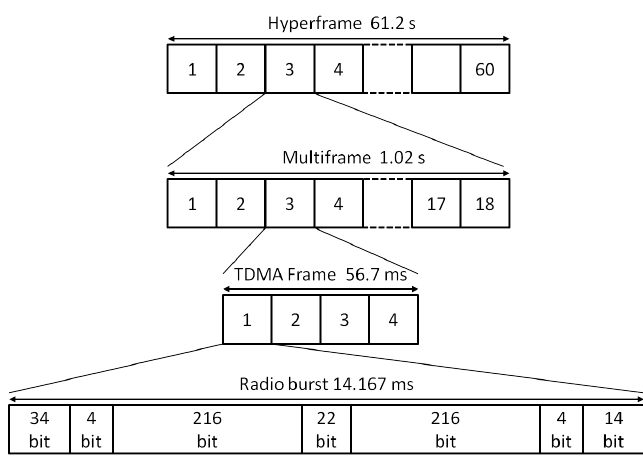
Figure 4. TETRA radio frame.